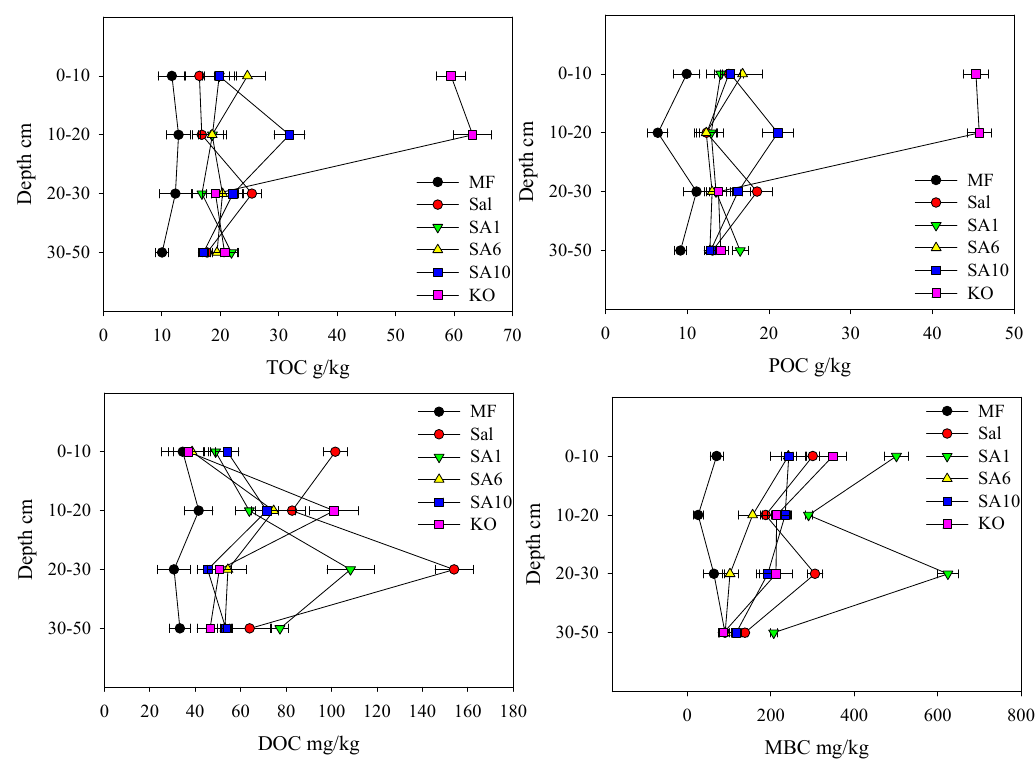
Figure 2. Vertical variation of different carbon in the sediment at different sites.